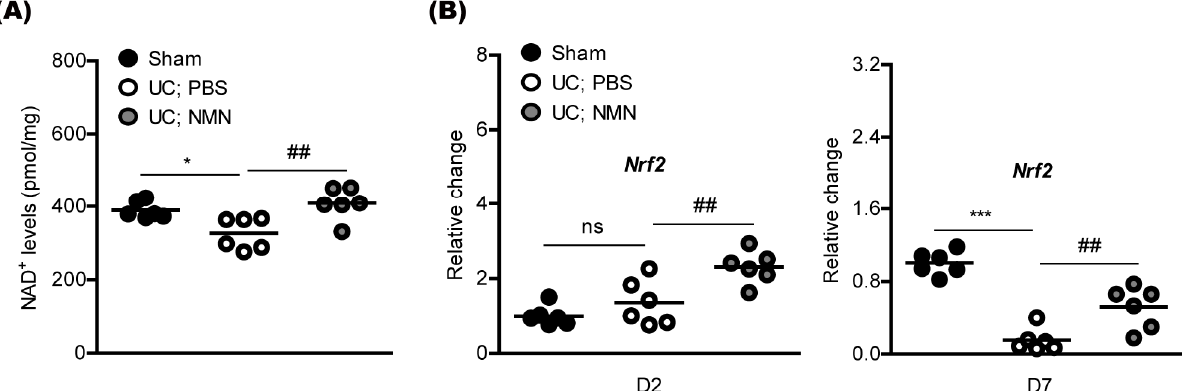
Figure 3. Modulation of redox balance and an antioxidant pathway by NMN treatment. ( A ) Quantitative analyses (n = 6 per group) demonstrated that retinal NAD + levels were significantly reduced by UCCAO. NMN treatment significantly suppressed its reduction. * p < 0.05; ## p < 0.01. One-way ANOVA followed by a Bonferroni post hoc test. A graph is shown as mean with actual values (mean and standard deviation, sham: 390.0, 23.38; UC; PBS: 326.2, 43.12; UC; NMN: 408.7, 44.13). ( B ) Quantitative analyses (n = 6 per group) demonstrated that NMN administration increased Nrf2 mRNA expression in the ischemic retina. *** p < 0.001; ## p < 0.01; ns, not significant. One-way ANOVA followed by a Bonferroni post hoc test. A graph is shown as mean with actual values (mean and standard deviation, sham: 1.00, 0.26; UC; PBS: 1.35, 0.60; UC; NMN: 2.30, 0.43; sham: 1.00, 0.12; UC; PBS: 0.15, 0.12; UC; NMN: 0.51, 0.23). UC, UCCAO; D, day.